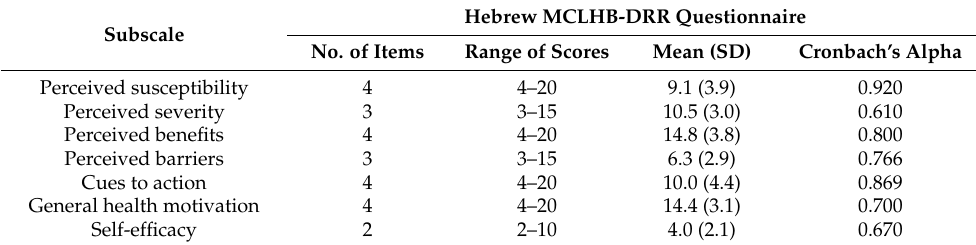
Table 3. Means and internal consistency of the subscales ( N = 328) a